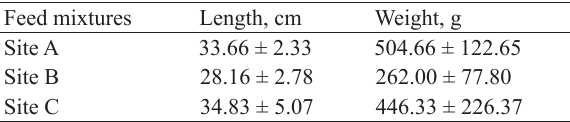
Table 6 Biometric characteristics of farmed rainbow trout sampled from different farming sites